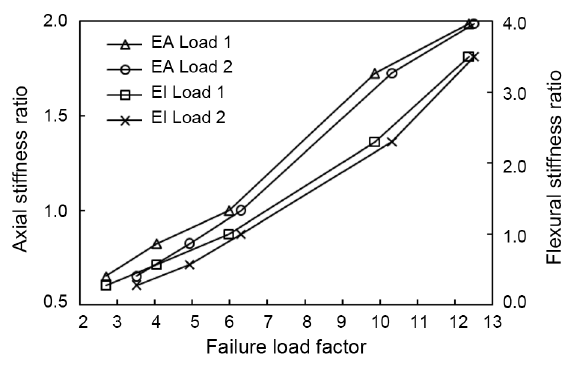
Fig. 13. Failure loads with different cross-sections of steel beams